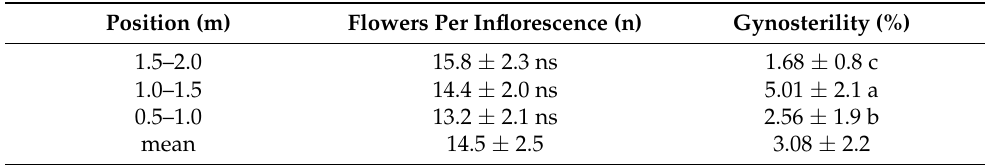
Table 4. Flower per inflorescence (n) and gynosterility (%) of cv. Lecciana as effect of inflorescence position along the canopy. Mean values of two subsequent seasons ( ± SE ). Lower case letters denote statistical differences at p = 0.05 (Siegel-Tukey test); ns = not significant.